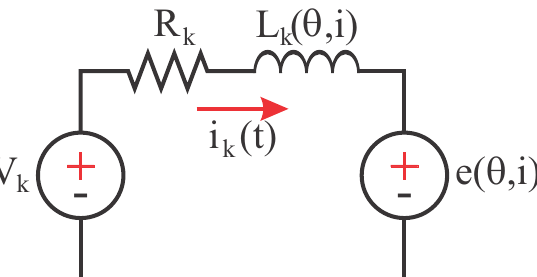
Figure 1. Equivalent phase circuit of a switched reluctance machine (SRM) disregarding magnetic coupling and considering constant phase